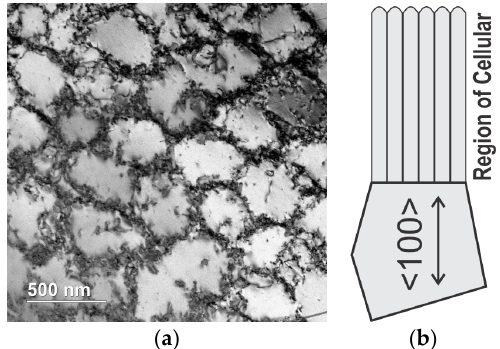
Figure 6. ( a ) Cellular structures in SLM 316L, with arrays of dislocations piling up at cell boundaries. Build direction points out of the paper; ( b ) Schematic illustration of grain boundaries and cell boundaries [11].